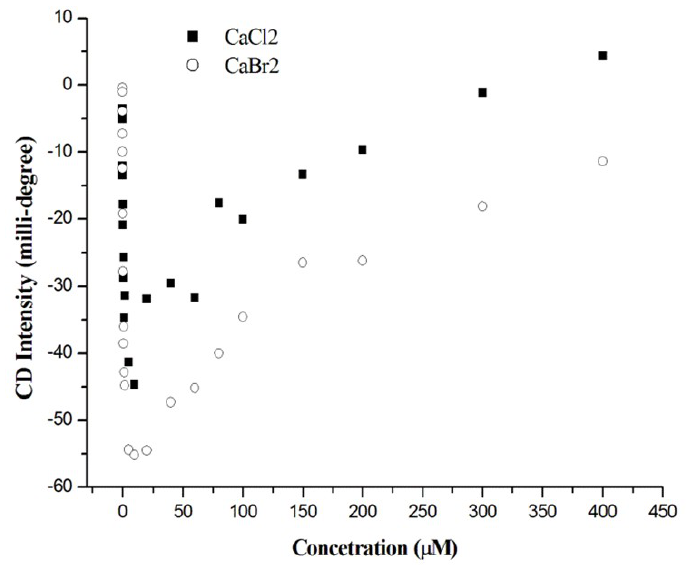
Figure 2. The intensity of the CD signal at 228 nm vs. the Ca salt concentration. The titration curves for one hundred micromolar gramicidin A titrated with CaCl 2 ( ⯀ ) and CaBr 2 ( ○ ) in methanol, respectively.